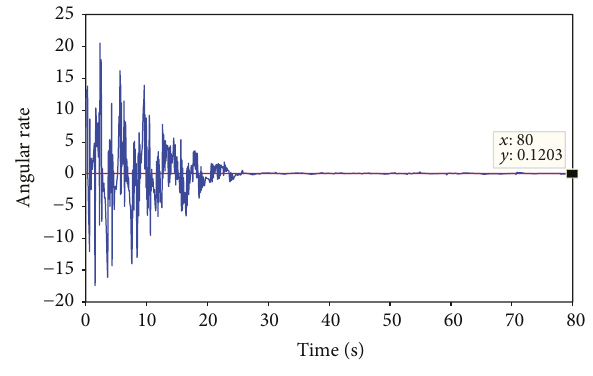
Figure 11: Adaption of angular velocity. Table 1: RMS errors of the x - and y -axes under di ff erent fractional